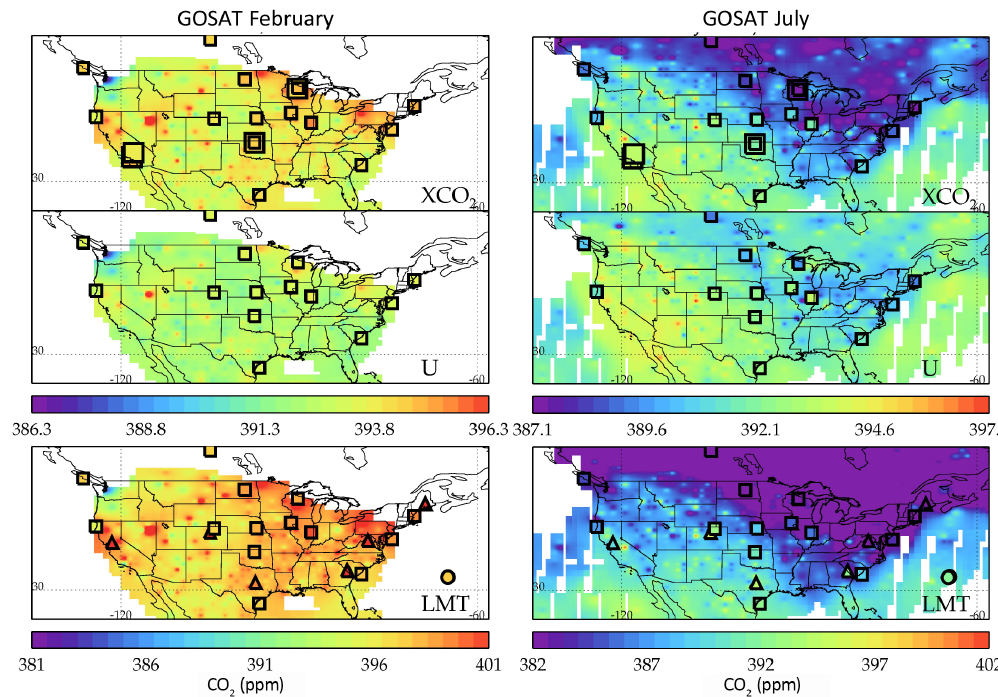
Figure 6. GOSAT X CO 2 (top), U (middle), and LMT (bottom) in February (left) and July (right). Aircraft with GOSAT averaging kernels are small squares, towers are triangles, remote ocean surface sites are circles, and TCCON are large squares (only shown on X CO 2 panels). Data are averaged over the GOSAT